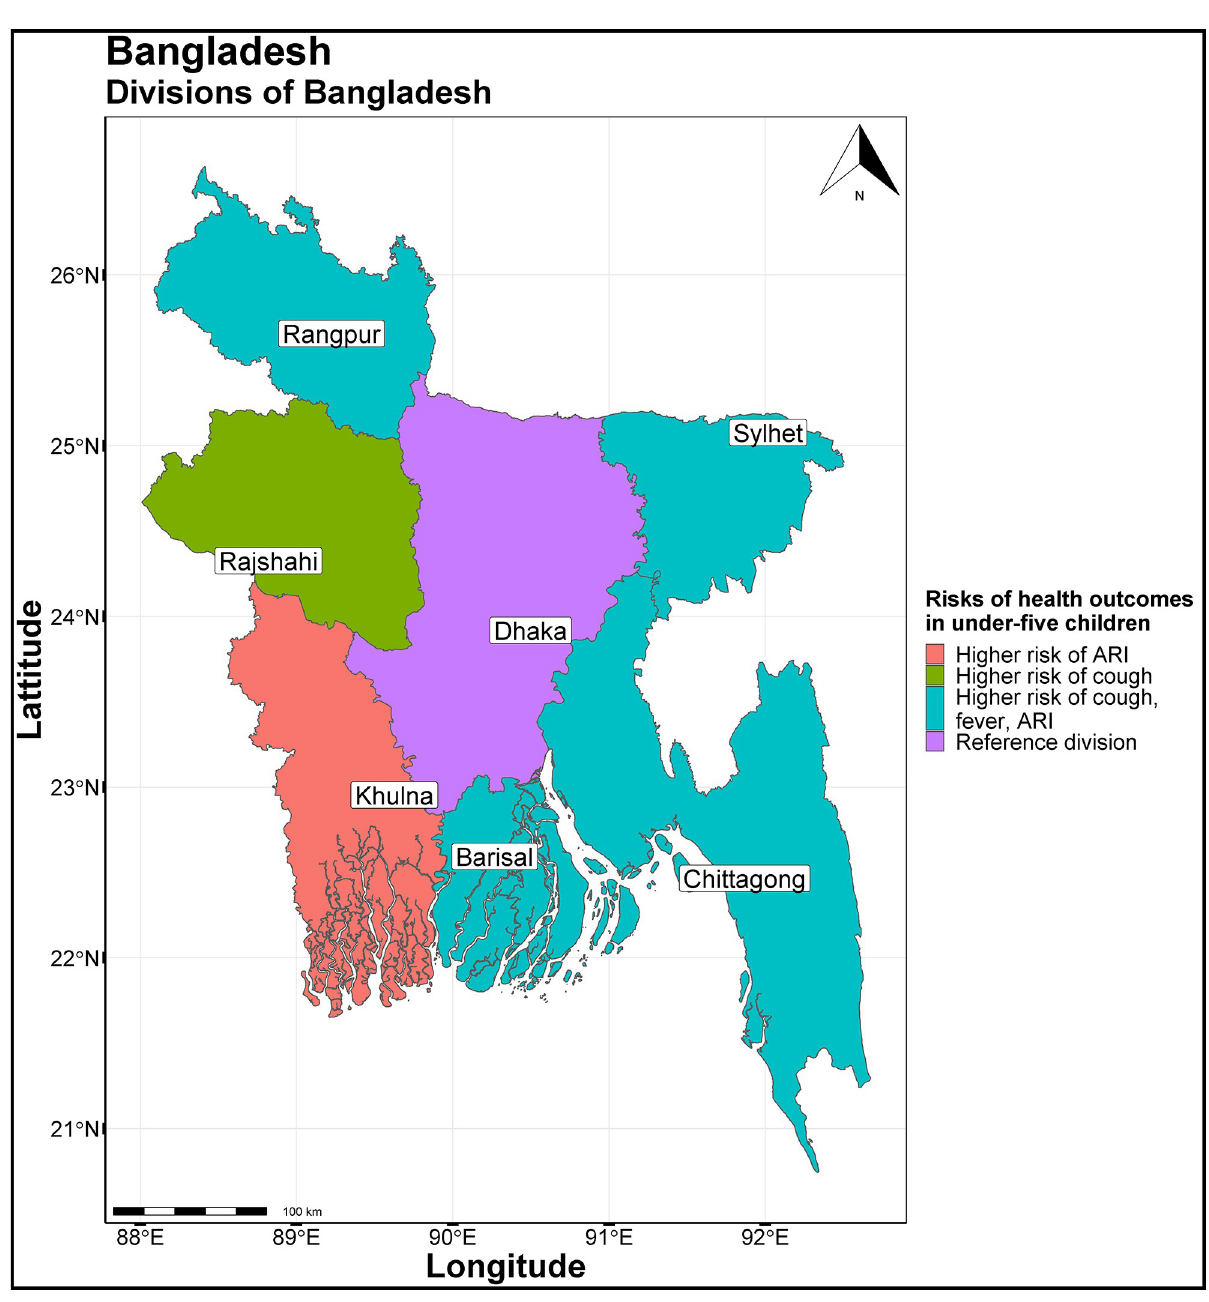
Fig 5. Health outcomes of children under five years old (U5y) living in slums in different divisions of Bangladesh. R software was used to create the map. The source of the basemap shapefile is available on GADM website at: https://geodata.ucdavis.edu/gadm/gadm4.1/shp/gadm41_BGD_shp. zip. The data are freely available for academic use and other non-commercial use (CC-BY 2.0). The GADM license is available at https://gadm.org/ license.html.